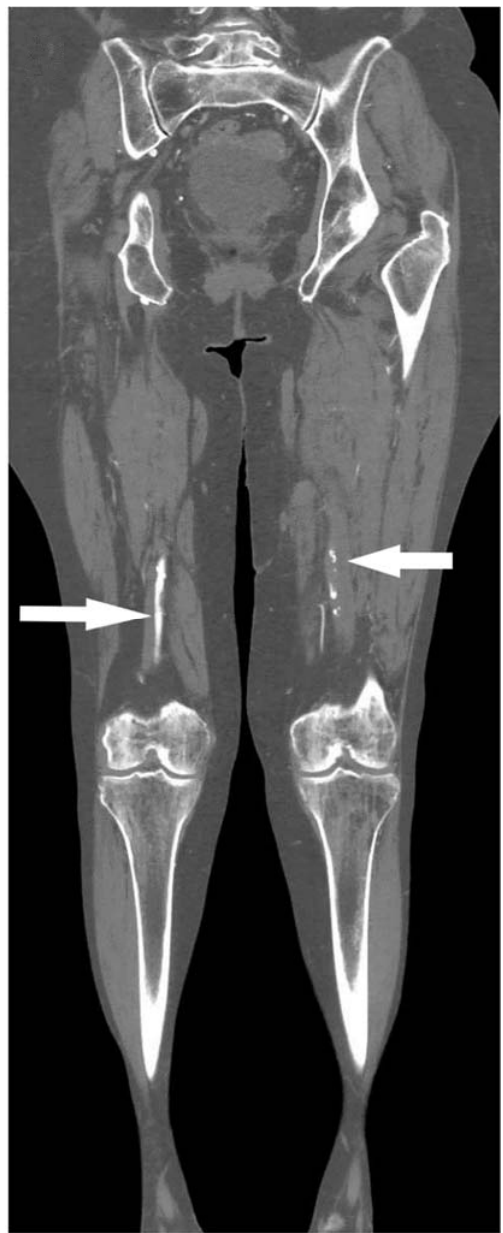
Figure 3. Coronal computed tomography angiography shows occlusion of the left common femoral artery (white arrows), the same patient as in Figure 2.